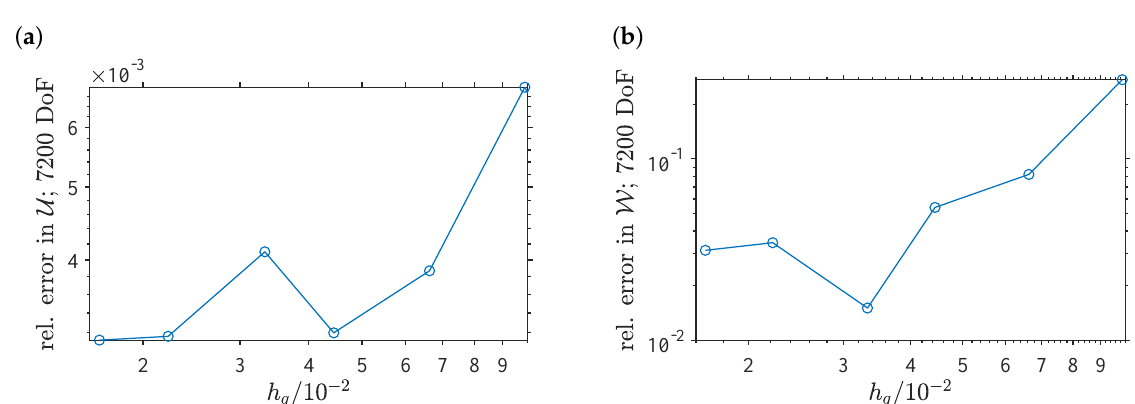
Figure A2. Numerical convergence of the swimming problem with the free-slip boundary condition, calculated with the nearest-neighbor discretisation and the full regularised stokeslet boundary integral formulation. ( a , b ) relative error in U , W at fixed force degrees of freedom 3 N = 7200 and varied quadrature spacing h q .